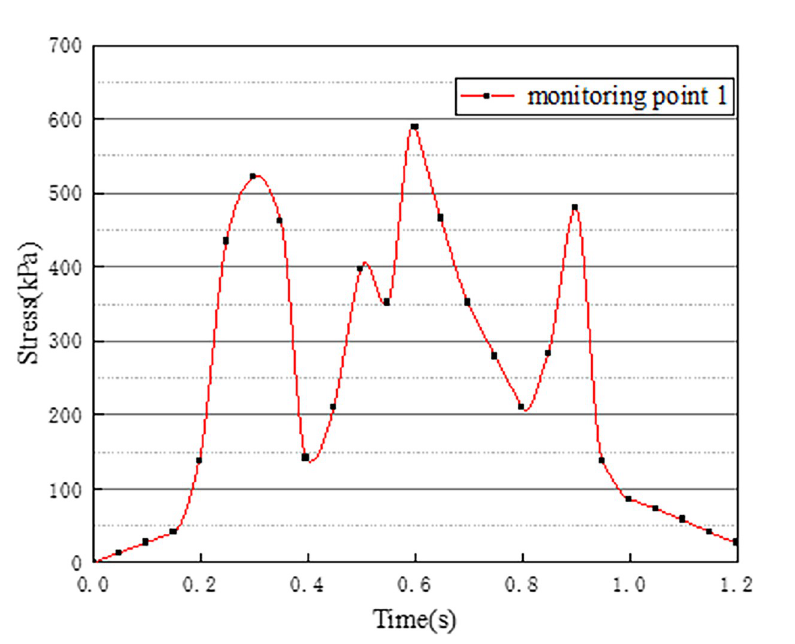
Fig 7. Stress time history curve of monitoring point 1.